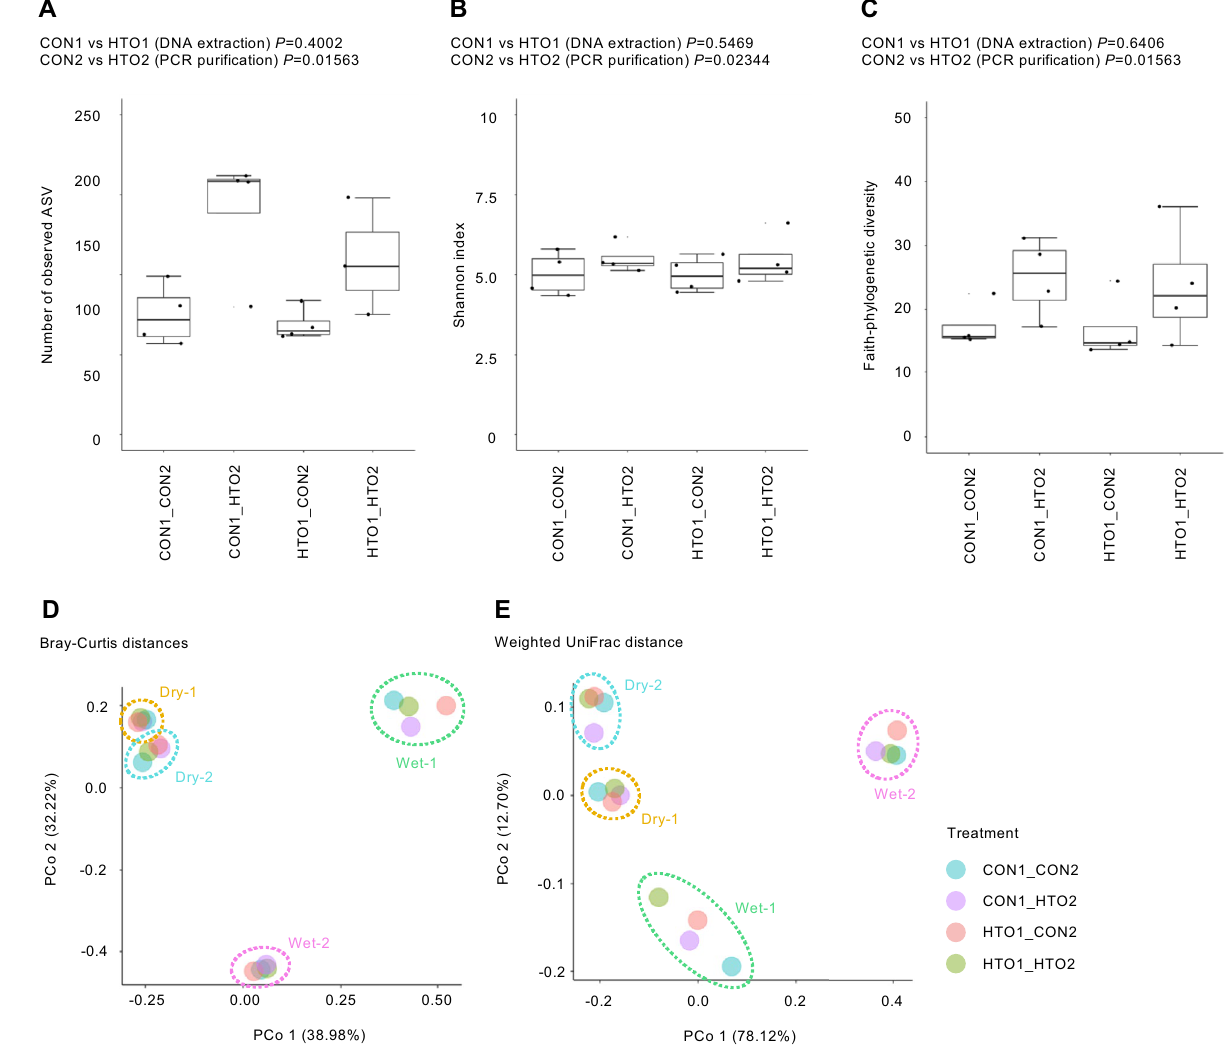
Figure 3. Plant microbial community diversity among different methods. Alpha diversity metrics of the number of observed ASVs ( A ), Shannon diversity ( B ), and Faith phylogenetic diversity ( C ). Principal coordinate analysis based on Bray–Curtis distances ( D ) and weighted UniFrac distances ( E ). The circles with different colors indicate biological samples with different